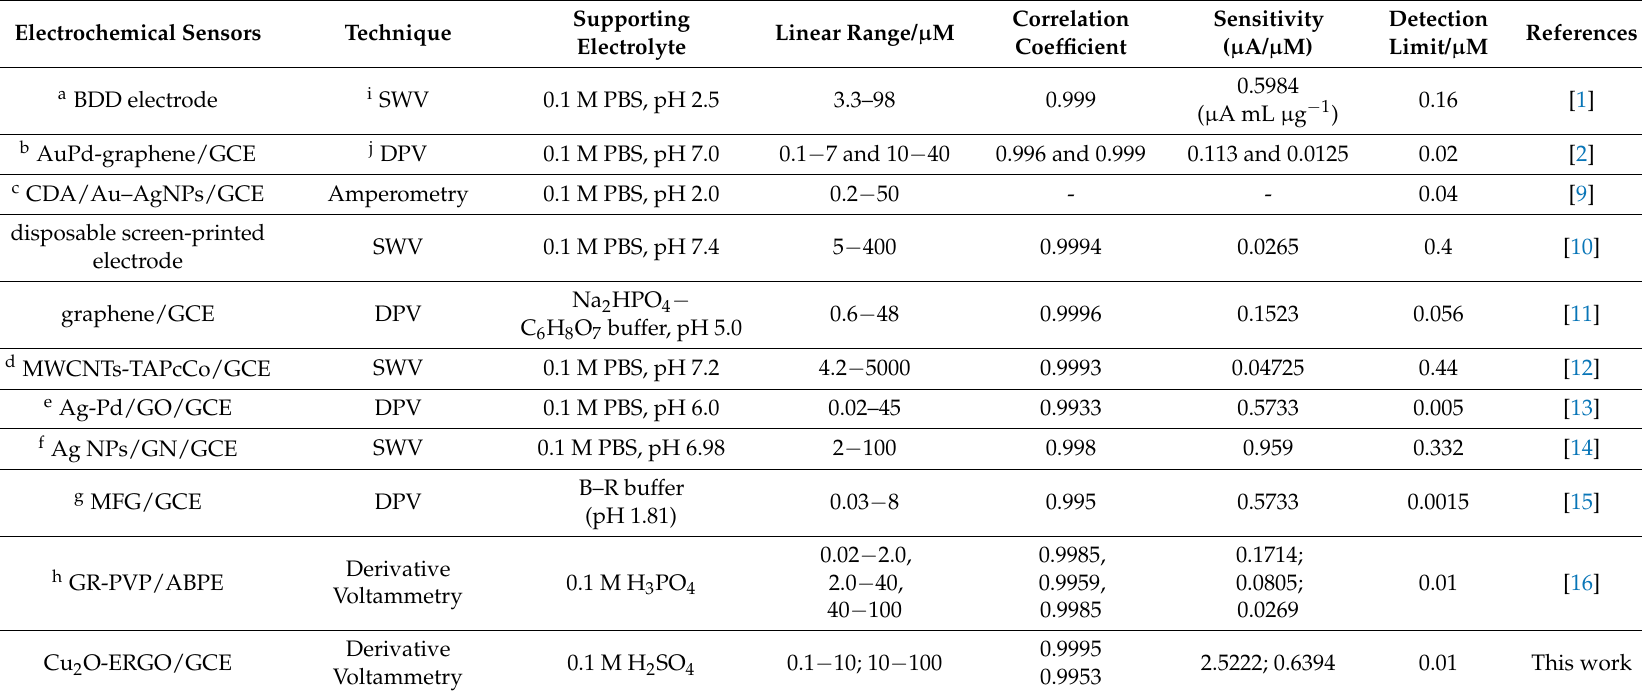
Table 1. Comparison with other electrochemical methods for the determination of